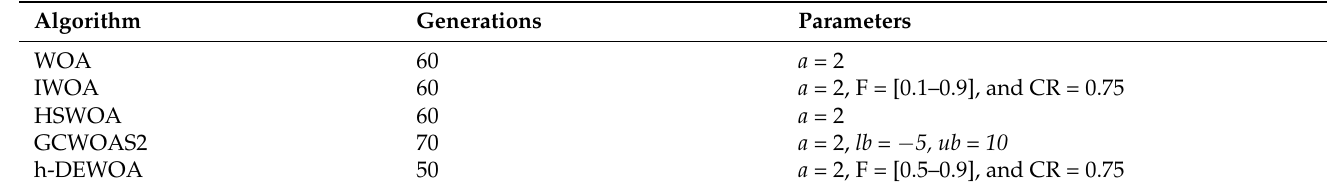
Figure 6. Convergence examination of algorithms with PopSize = 60 for CEA-Curie workload for first series of experiments. Table 9. Optimal parameter settings of algorithms for the first series of experiments for 30 indepen- dent